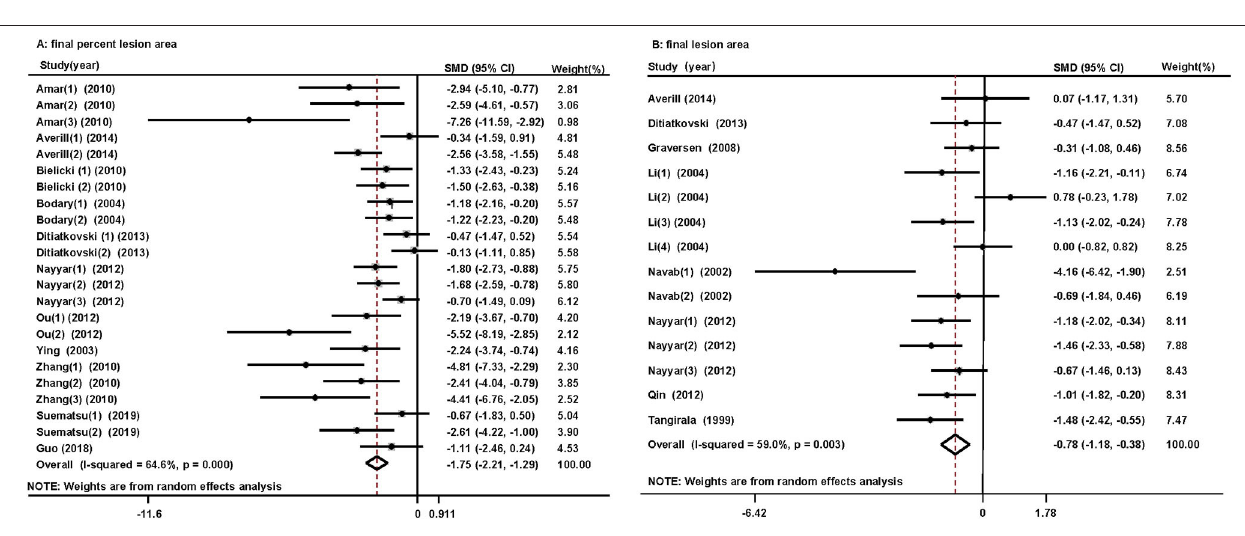
inducing a 133.2% increase in HDL-C levels (53). One